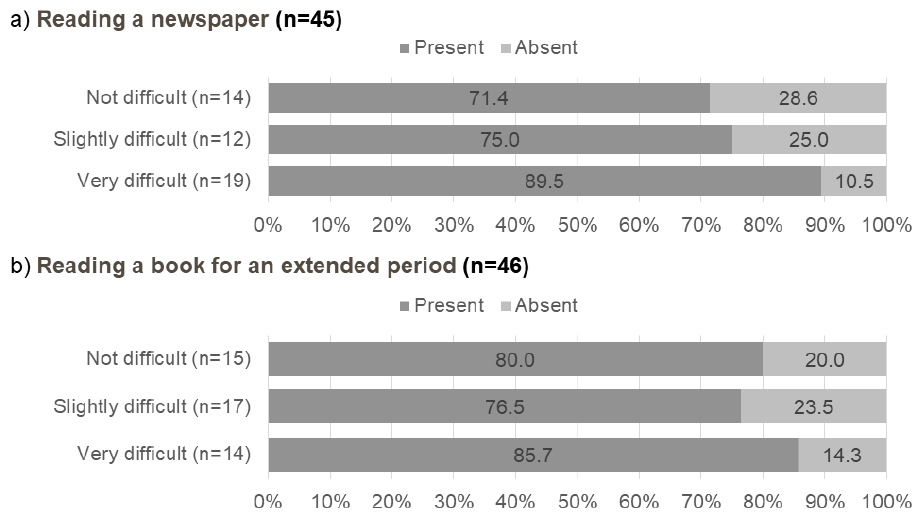
Figure 3. Awareness of presbyopia and subjective symptoms for near tasks in patients aged 45 years and older ( n = 55).